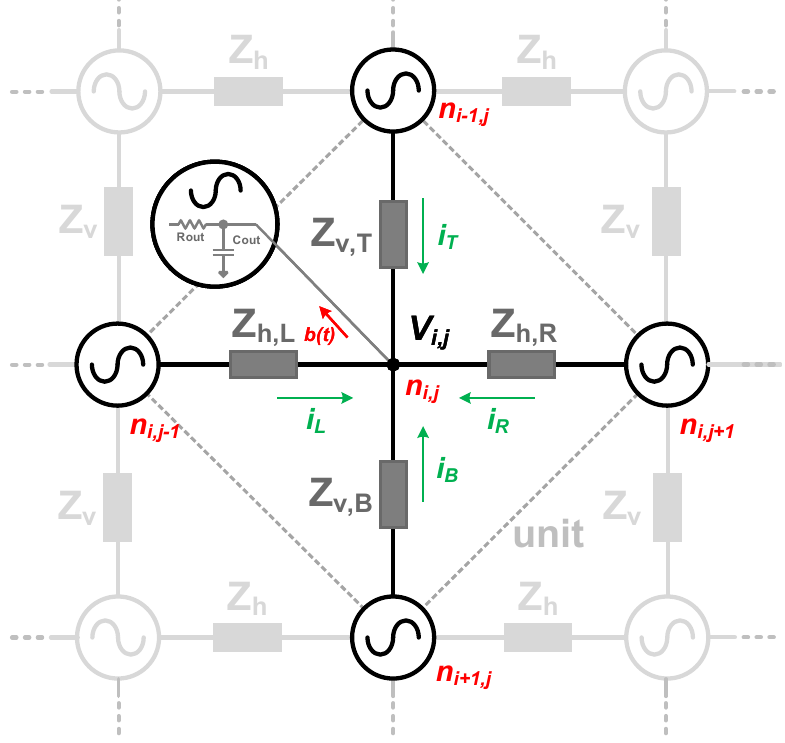
Figure 4. Generic mutually coupling oscillators